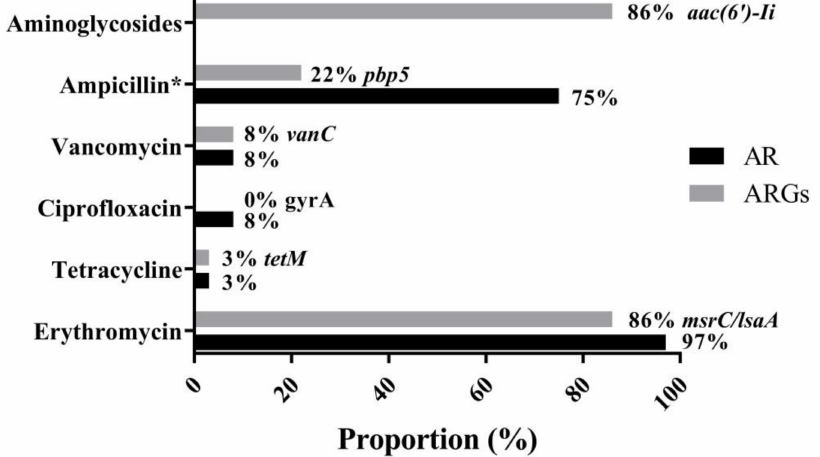
Figure 4. Major antimicrobial resistance phenotype (AR, antibiotic resistance) and genotype (ARGs, antibiotic resistance genes) in 36 enterococci. Resistance rates against erythromycin (97%), van- comycin and ciprofloxacin (8%), tetracycline (3%), and aminoglycosides (0%) were found in 36 entero- cocci, respectively. * indicates an isolate with an MIC of ampicillin of >2 µ g/mL. High detection rates of msrC / lsaA (86%), aac(6 (cid:48) )-Ii (86%), followed by pbp5 (22%), v anC (8%), tetM (3%), and ciprofloxacin resistance gene (0%) were observed,